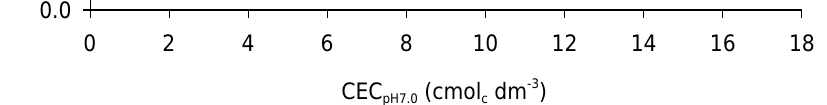
Figure 4. Relationship between potassium buffering capacity (KBC) and the cation exchange capacity (CEC pH7.0 ) of 23 soil samples representative from Rio Grande do Sul and Santa Catarina states, Southern